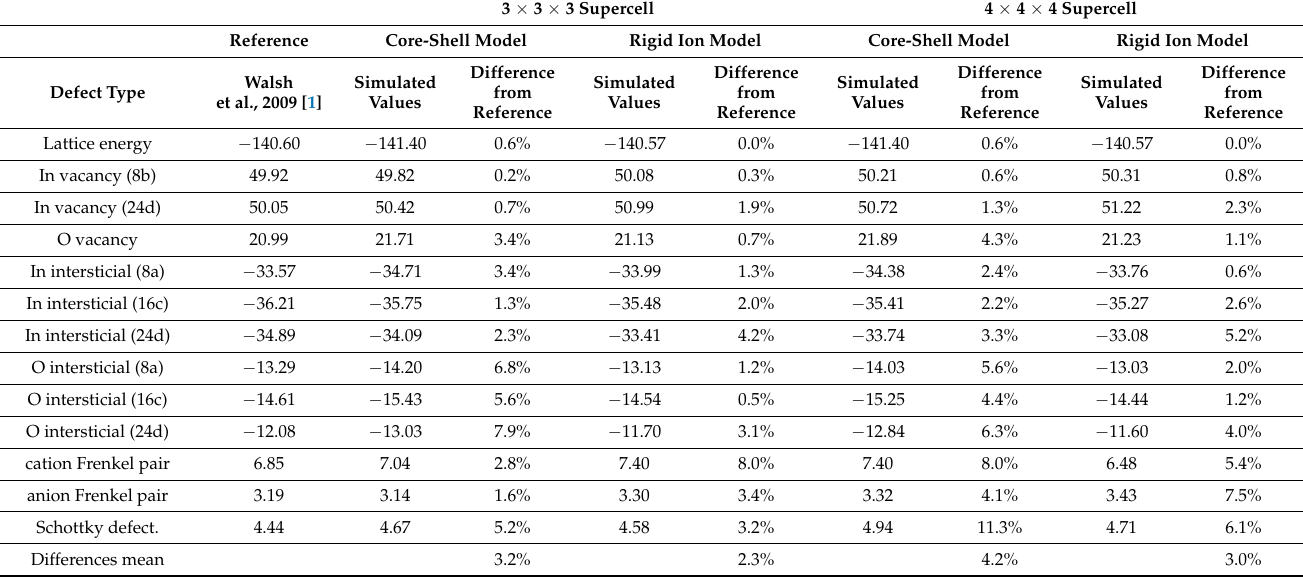
Table 4. In 2 O 3 defect energies in